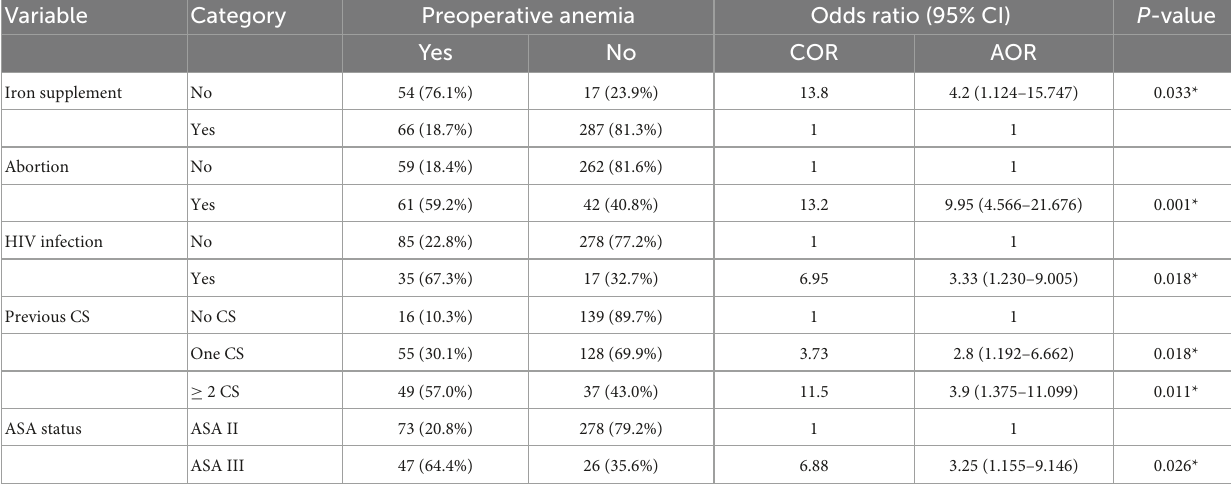
TABLE 3 Multivariable logistic regression analysis of associated factors of preoperative anemia among women undergoing CS at University of Gondar comprehensive specialized referral hospital, 2022 ( N = 424).